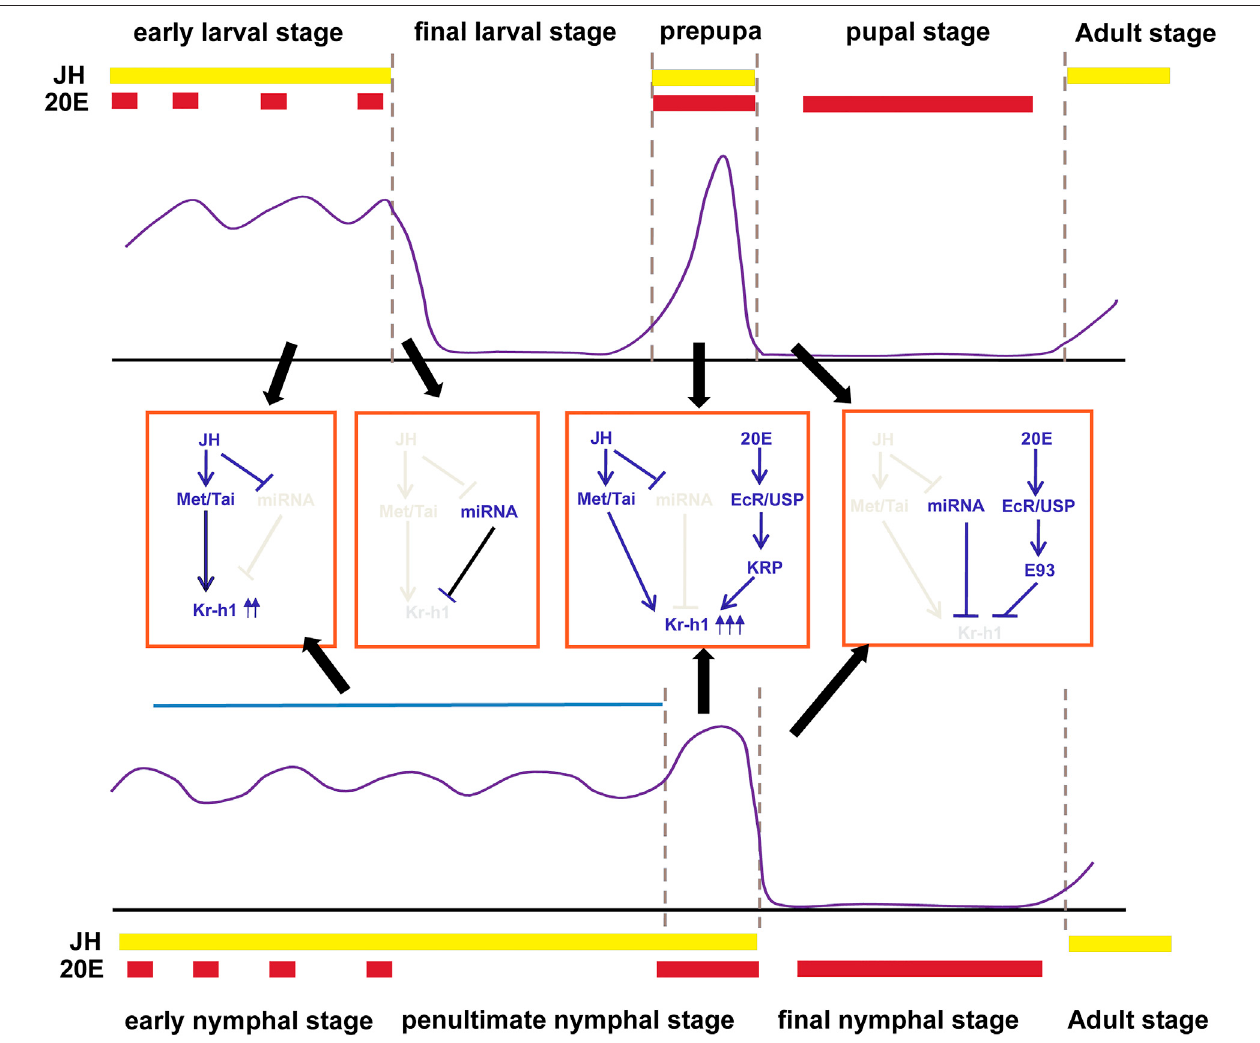
FIGURE1| Transcriptionalregulationof Kr-h1 inholometabolousinsects(Toppanel)andhemimetabolousinsects(bottompanel).Theexpressionpatternof Kr-h1 duringinsectlifehistoryisshowninthepurpleline.Themiddleistheregulatorymechanismduringeachstageofdevelopment.Theapproximatetimesof20Epulsesand JH levels in holometabolous insects and hemimetabolous insects are shown in red and yellow boxes at the top or bottom of each panel, respectively. Gene expression pro fi les for Kr-h1 refers to Belles and Santos (2014) and Martin et al. (2021). JH and 20E titers are from Martin et al. (2021).